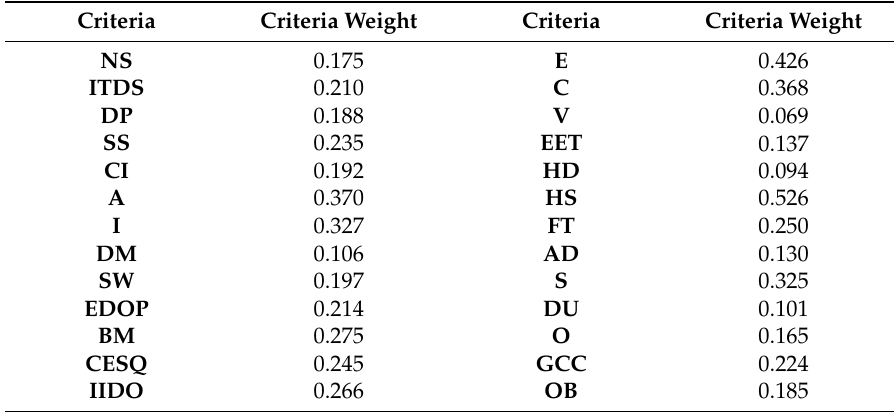
Table 6. Degree of importance of the